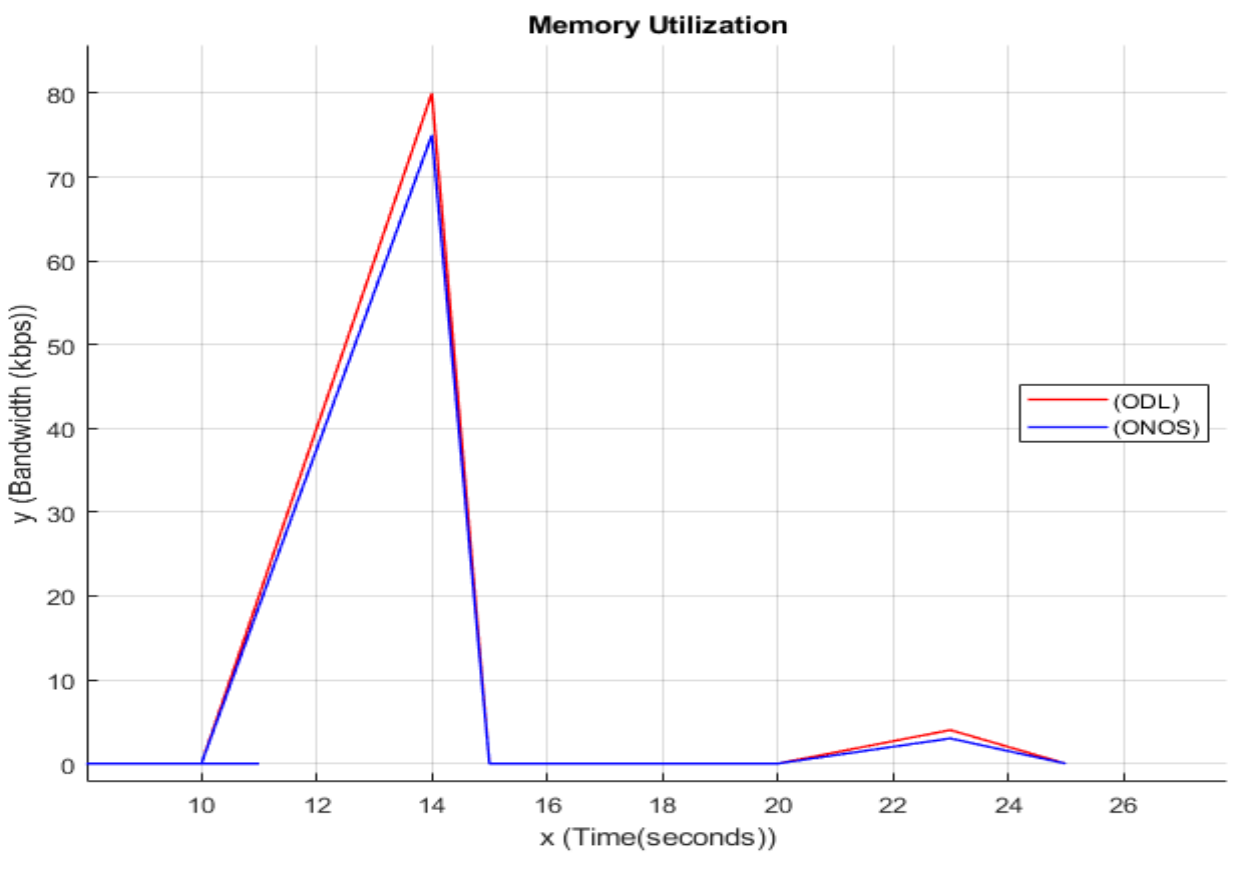
Figure 5. Memory utilization.